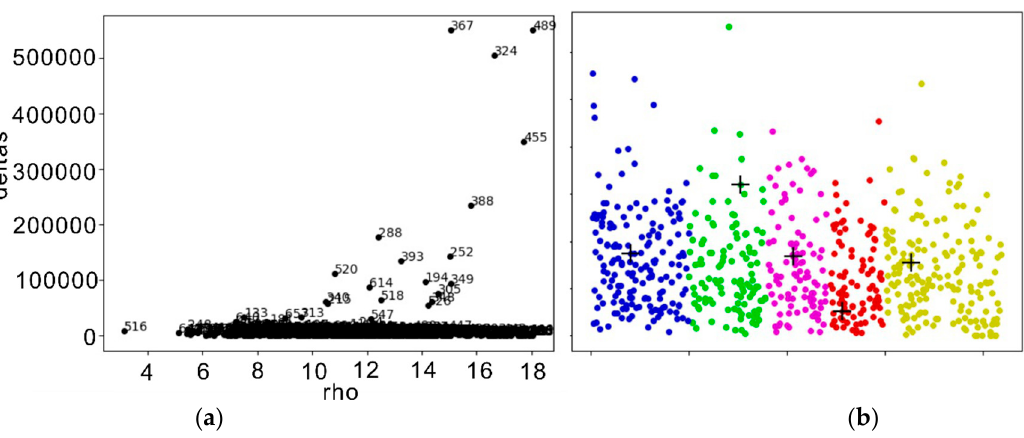
Figure 5. Flowchart of the semi-supervised learning framework. ( a ) Cluster center distribution map. ( b ) Cluster distribution map.